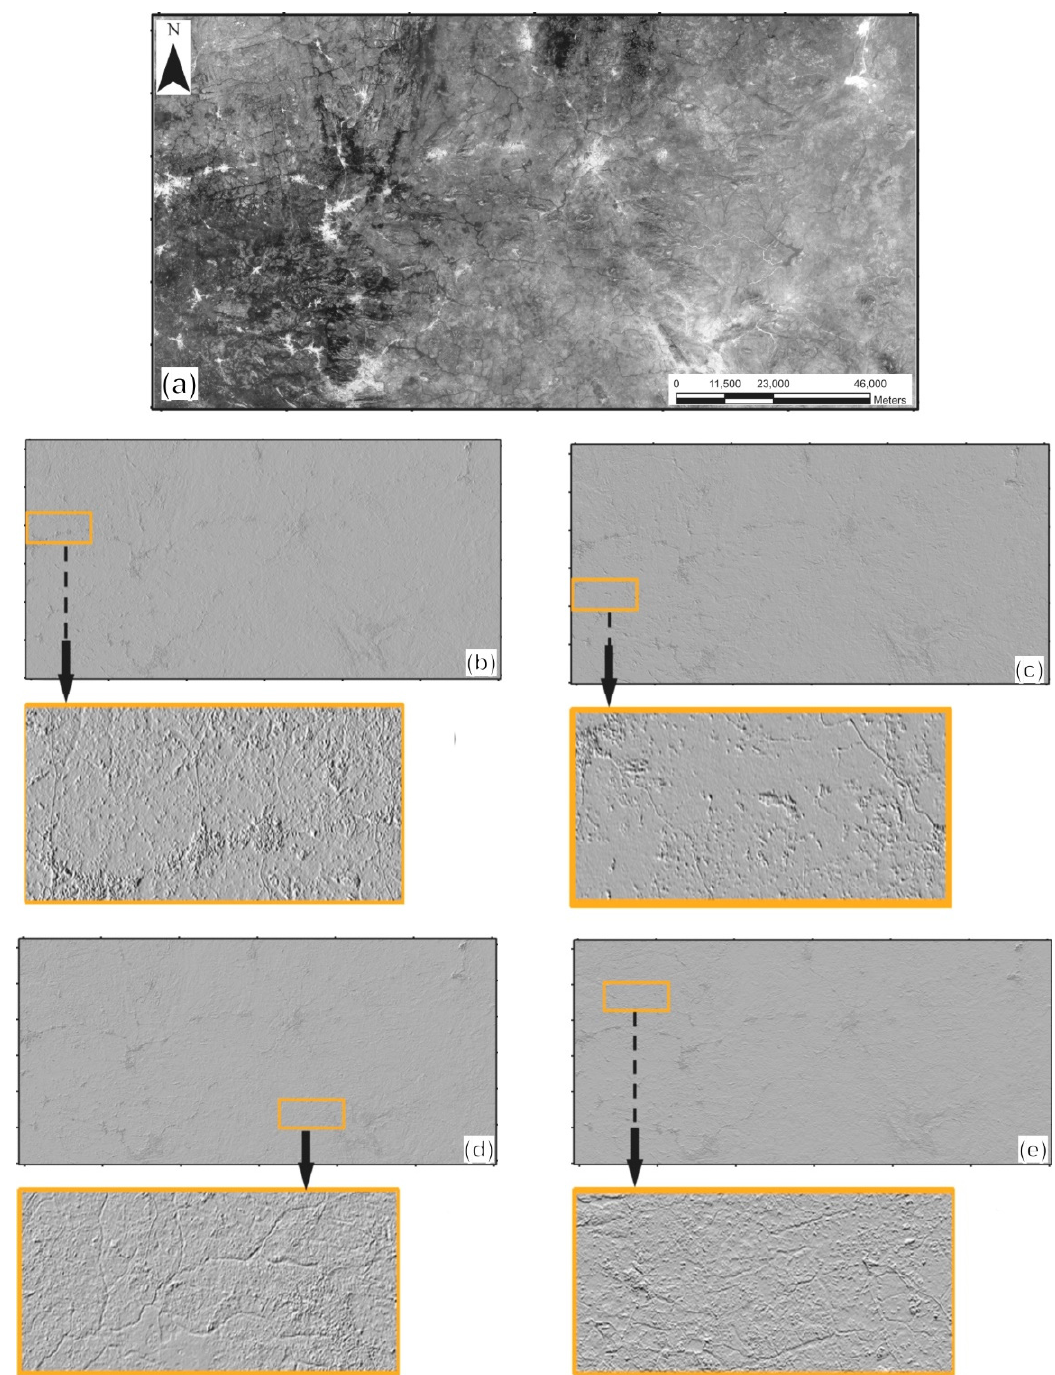
Figure 7. The output of the application of Sobel directional filters modified from [94]; ( a ) Band 8 of Landsat 8 OLI/TIRS (original image), ( b ) filtered image with N-S direction, ( c ) filtered image with NW-SE direction, ( d ) filtered image with NE-SW direction, and ( e ) filtered image with E-W direction.